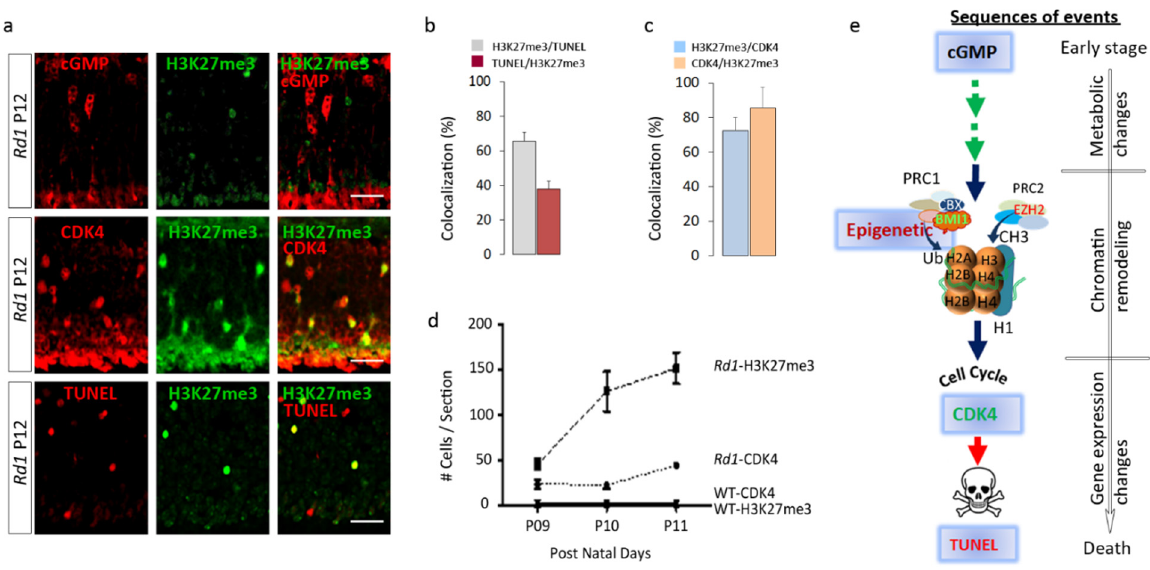
Figure 3. H3K27me3 h mark increase is an intermediate event between the cGMP accumulation and DNA fragmentation (TUNEL) in Rd1 mice. ( a ) Photoreceptor cells in Rd1 retina were double stained with H3K27me3 and either cGMP (top panel), CDK4 (middle panel) or TUNEL (bottom panel). No co-localization was seen with cGMP and H3K27me3, whereas fractions of CDK4 and TUNEL-positive cells also contained H3K27me3. ( b ) Bar graph representing the percentage of cells with H3K27me3 and TUNEL or ( c ) CDK4 at PN12. Note that less than 40% of the TUNEL-positive cells are also H3K27me3-positive ( n = 4). ( d ) Time course analysis of CDK4 and H3K27me3 in Rd1 and WT mice at PN 09, 10, and 11 ( n = 4 animals per age). The number of H3K27me3-positive cells peaks before CDK4 expression. ( e ) We propose this sequence of events during retinal degeneration (no evidence now of functional relationship). Scale bar = 20 µ m. Error bars indicate